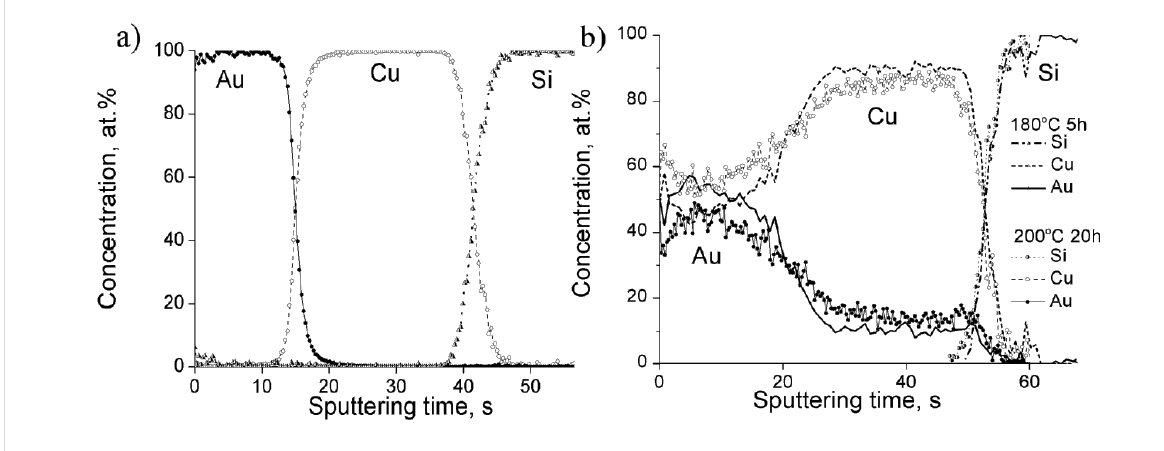
Figure 5: Concentration profiles of Au(25nm)/Cu(25nm) system a) as deposited sample and b) annealed samples.